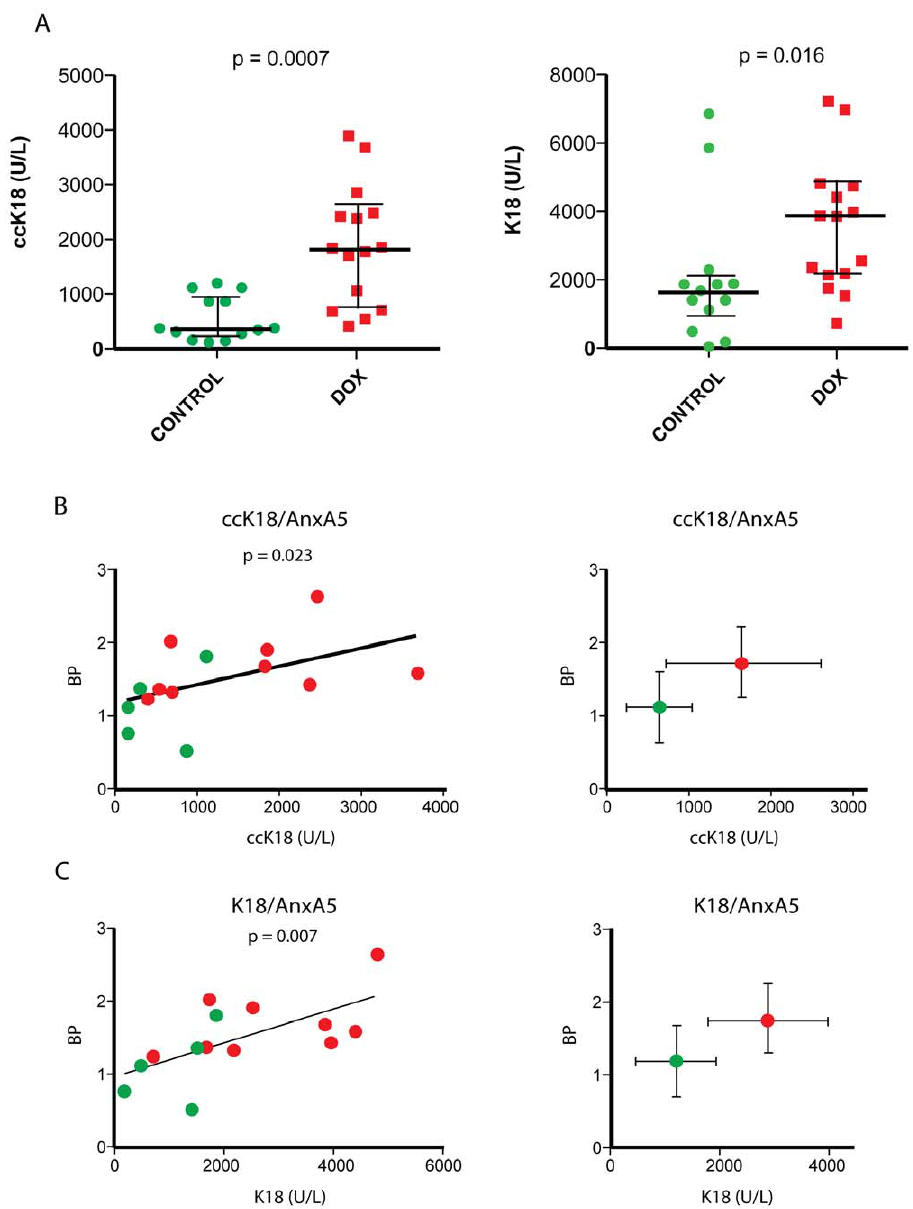
Figure 4. Correlations between increases in serum marker levels and tumor [ 11 C]-AnxA5-ST binding potentials upon doxorubicin treatment. A ) Levels of ccK18 (M30 Apoptosense H ) and K18 (M65 H ) determined in plasma of mice carrying FaDu xenograft tumors, either with (red symbols) or without (green symbols) prior doxorubicin treatment for 72 h. Statistical significance as given in the panels was determined by the Mann- Whitney U test. B,C ) Correlations between tumor binding potential in PET imaging using the [ 11 C]-AnxA5-ST tracer and B ) ccK18 and C ) K18 plasma levels for each mouse. Shown to the left in each panel are values of individual mice with the p-values of statistical analysis of correlation as performed using the Spearman rank test given in the graphs. The plots to the right show the aggregated means 6 S.D. Red symbols: doxorubicin-treated mice; green symbols: untreated mice.